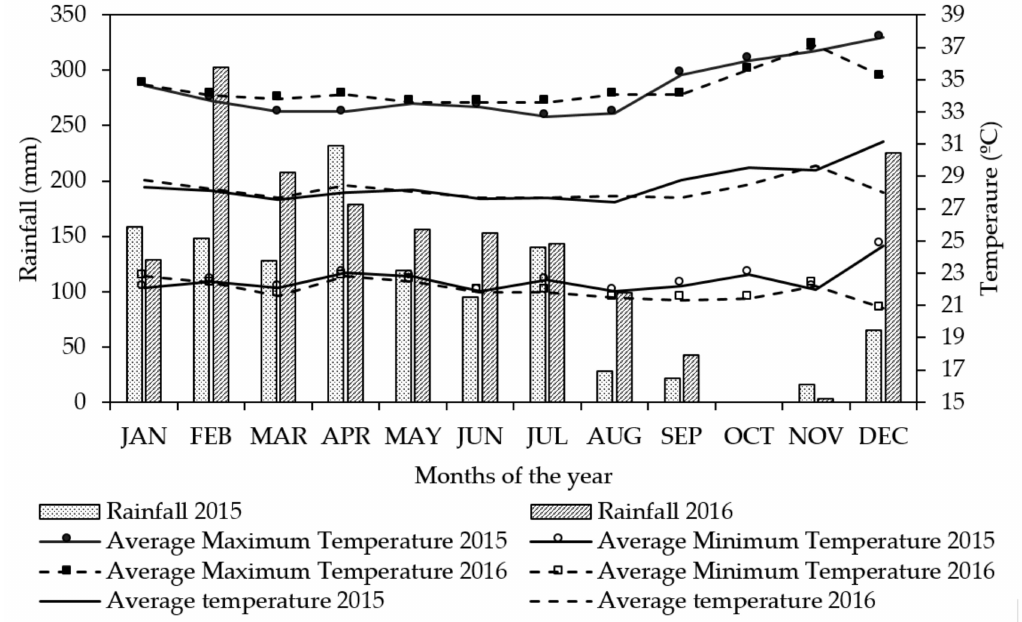
Figure 1. Monthly total rainfall and average temperatures during the experimental